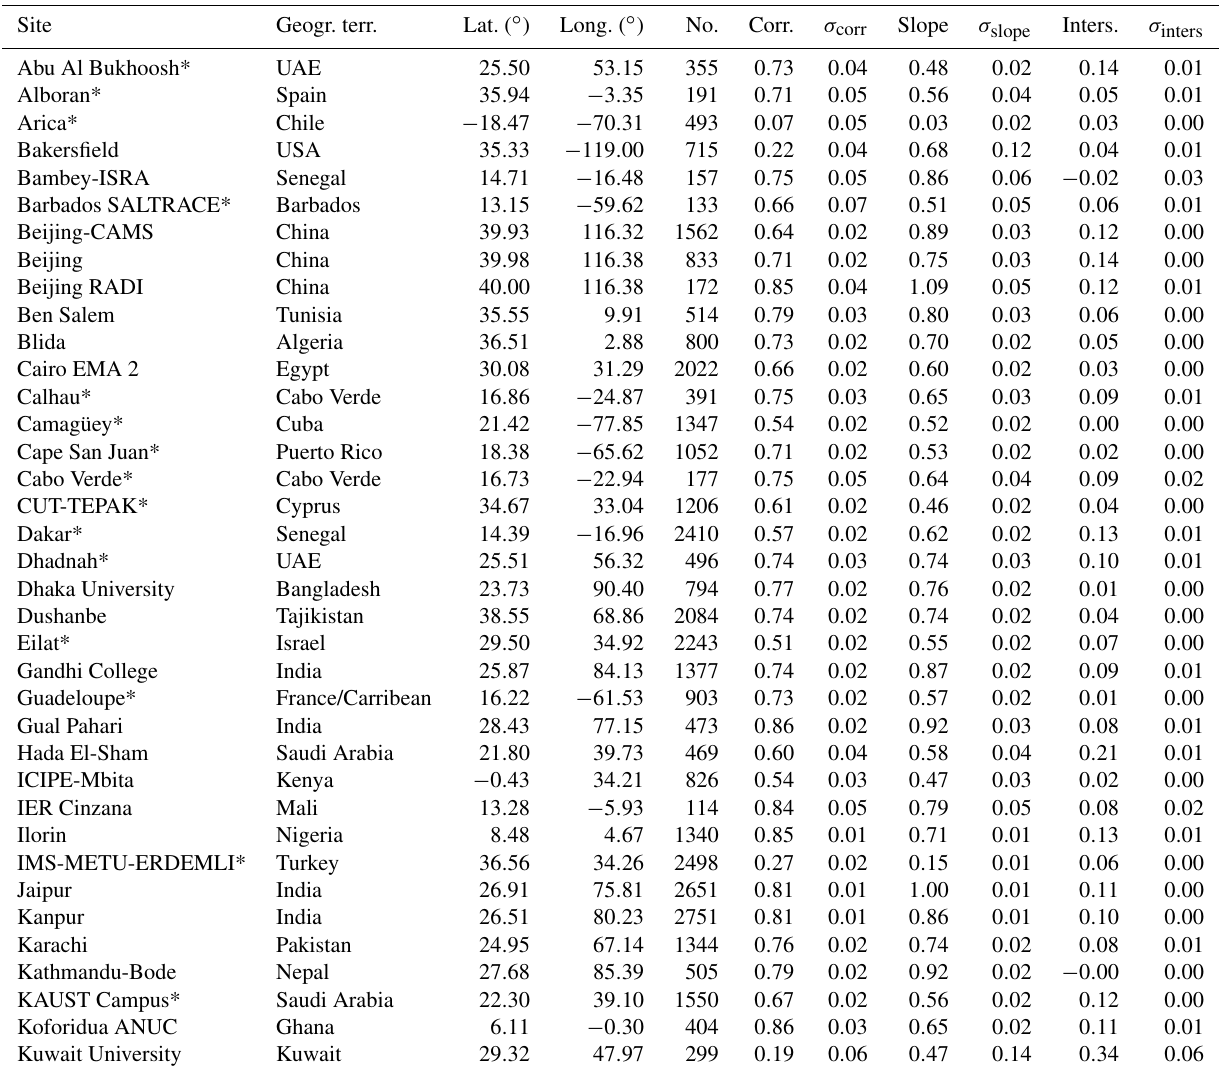
Table A1. List of the 72 AERONET sites selected for the evaluation study, together with their geographical coordinates and the results from the regression analysis: geographical location, latitude, longitude, number of observations used in the analysis, Pearson correlation coefficient between AOD at the site and MAPIR, slope and y intersection of the regression line. The standard deviation of the correlation and regression parameters is also given. Coastal sites where the AERONET coarse-mode AOD is potentially impacted by sea salt are marked with an asterisk after their